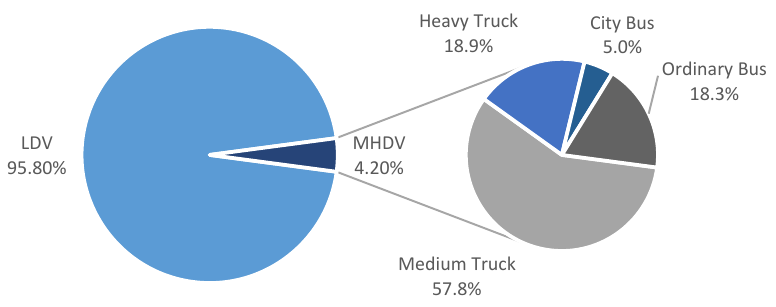
Figure 3. The ratio of MHDV to total road vehicles.